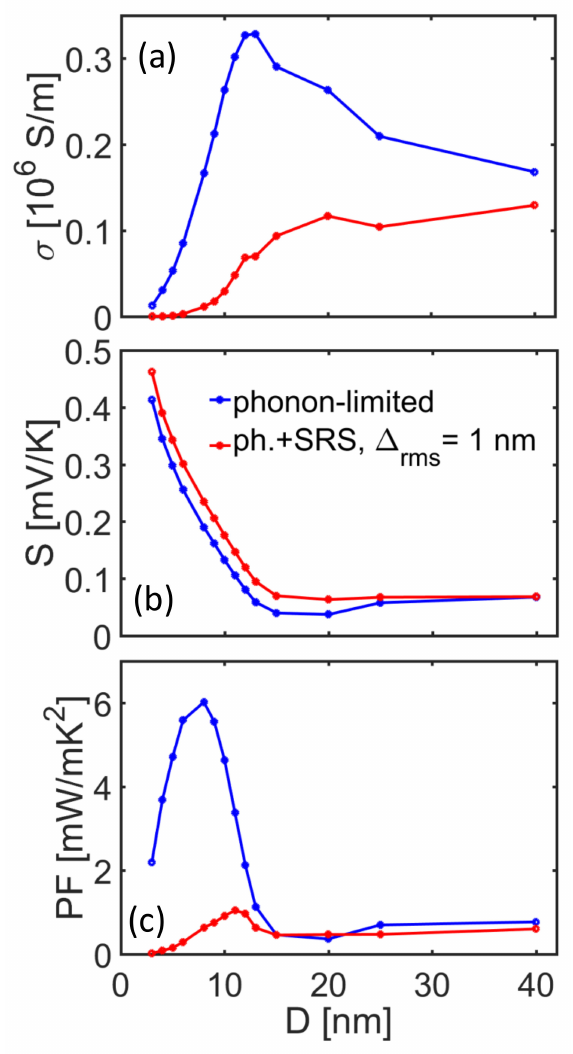
Figure 6. Thermoelectric coe ffi cients under phonon (blue lines) and phonon plus surface roughness scattering (red lines) transport conditions at room temperature for [100] InAs NWs versus diameter at a fixed carrier concentration of n = 10 18 / cm 3 . ( a ) Electrical conductivity, ( b ) Seebeck coe ffi cient, and ( c ) power factor. As the diameter is reduced, the Seebeck coe ffi cient is increased. The power factor is increased for diameters around d ~ 10